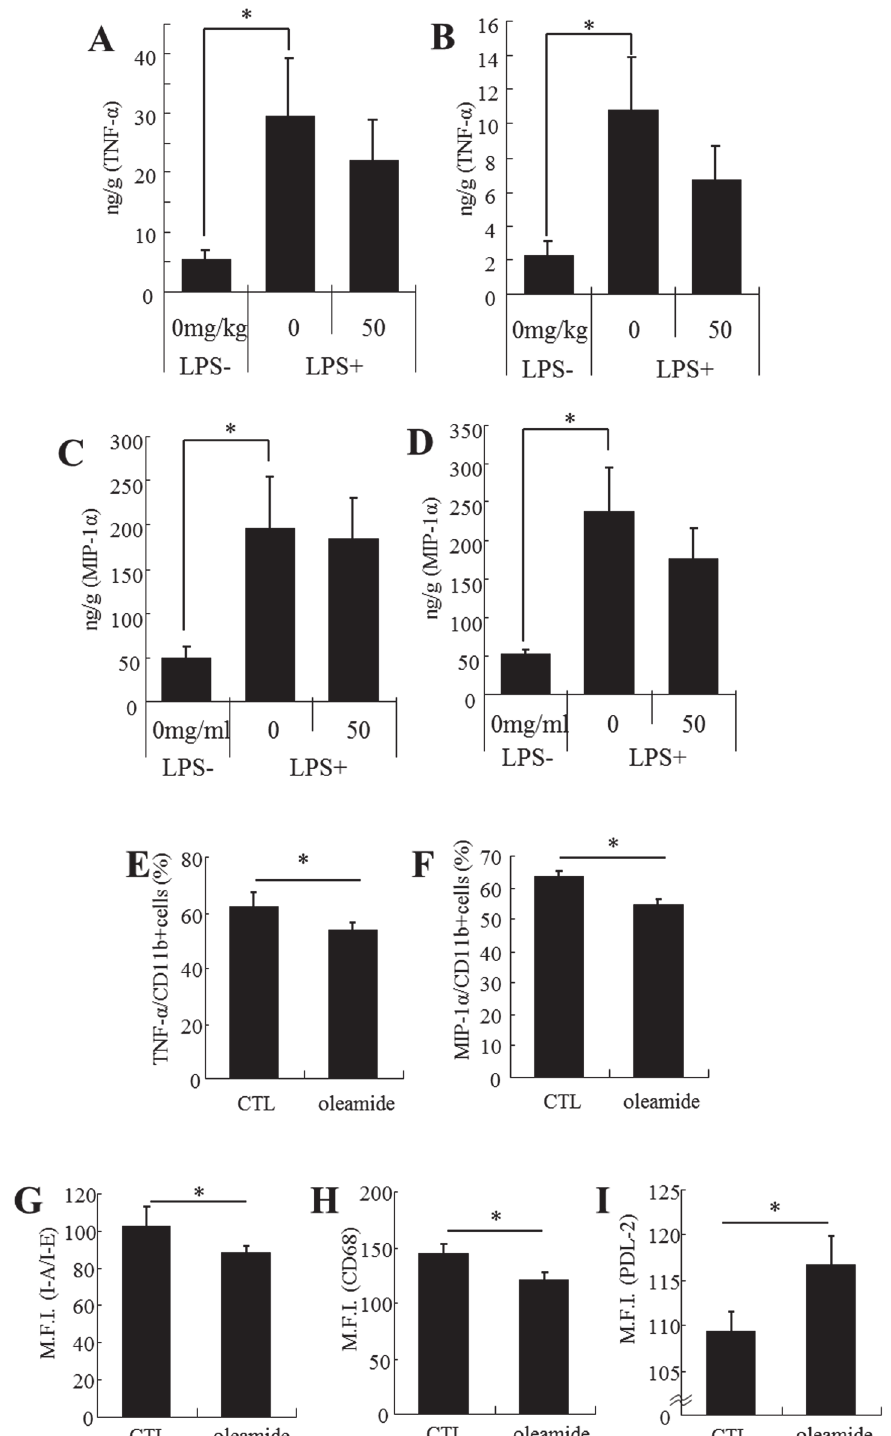
Fig 5. Effect of in vivo treatment with oleamide on microglial anti-inflammatory activity. CD-1 mice (n = 7/group) were orally given 50 mg/kg of oleamide once a day for 3 days and then injected intracerebroventricularly with either saline or 0.25 mg/kg of LPS. A and B , Quantification of TNF- α in the cerebral cortex and hippocampus, respectively. C and D , Quantification of MIP-1 α in the cerebral cortex and hippocampus, respectively. E and F , The ratio (%) of TNF- α -positive or MIP-1 α -positive cells to